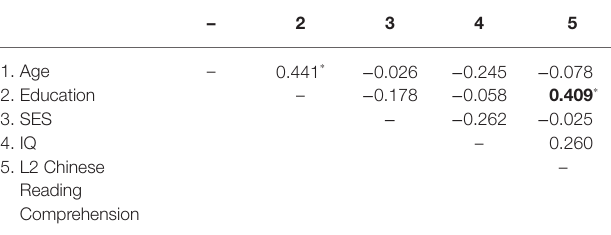
TABLE 3 | Pearson Correlations between demographic variables and L2 Chinese reading comprehension.